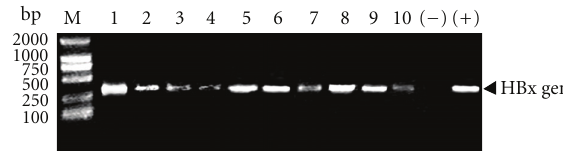
Figure 3: Examination of HBx gene in HCC tissues by PCR. The results revealed that the HBx gene-positive rate was 77.8% (35 / 45) in HCC tissues. The PCR products of no. 1–10 HCC patients were shown. ( − ) means negative control without adding template in the PCR system. (+) means positive control using the plasmid of pCMV-X cloned HBx gene as template in the PCR